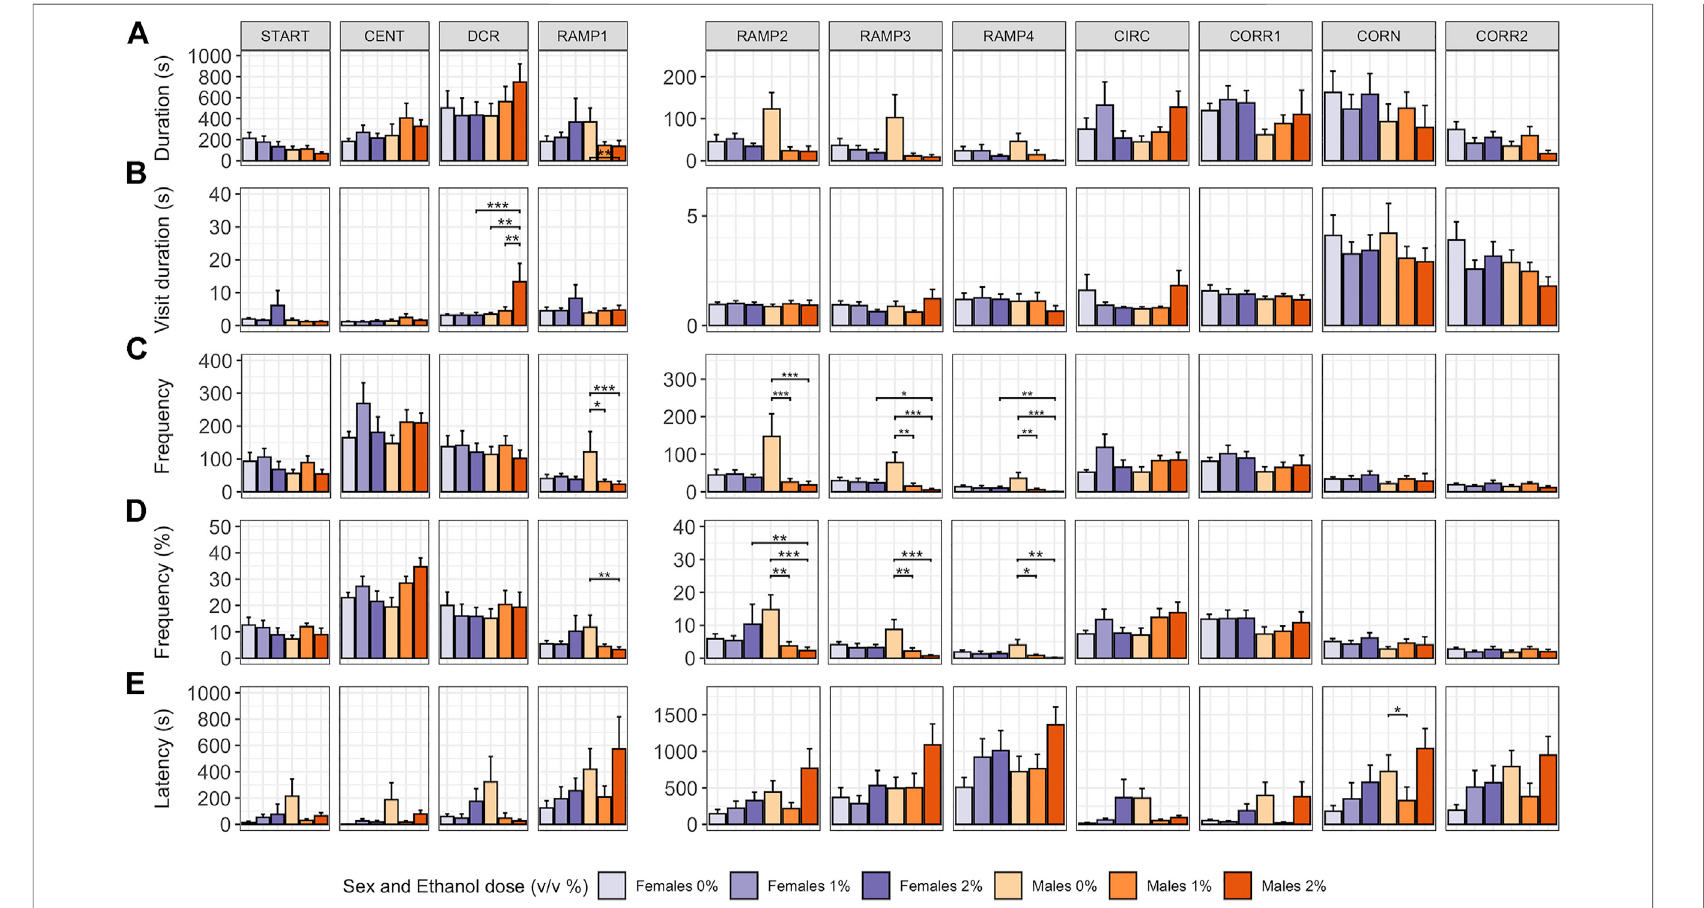
FIGURE 3 | Exploration of the zMCSF arena by male and female AB zebra fi sh acutely exposed to 0, 1 or 2% (v/v) ethanol for 30 min. Within each graph, the data is presented per Dose/Sex group. The different zonesarepresentedindifferentcolumns.Rowscontaindifferentresponsevariables: (A) Durationinzone(s), (B) Durationpervisitinzone(s), (C) Frequencyofzoneentries, (D) Frequencyofzoneentries(aspercentageof the total number of zone entries) and (E) Latency (s) until fi rst entry into a zone. Colors indicate Dose/Sex group as follows: females (purple colors) and males (orange colors) zebra fi sh exposed to 0% (controls; light shades), 1% ethanol (medium dark shades) or 2% ethanol (dark shades). Bars represent mean ± SEM over the 30-min trial. Stars indicate signi fi cant differences (* p < 0.05, ** p < 0.01, *** p <